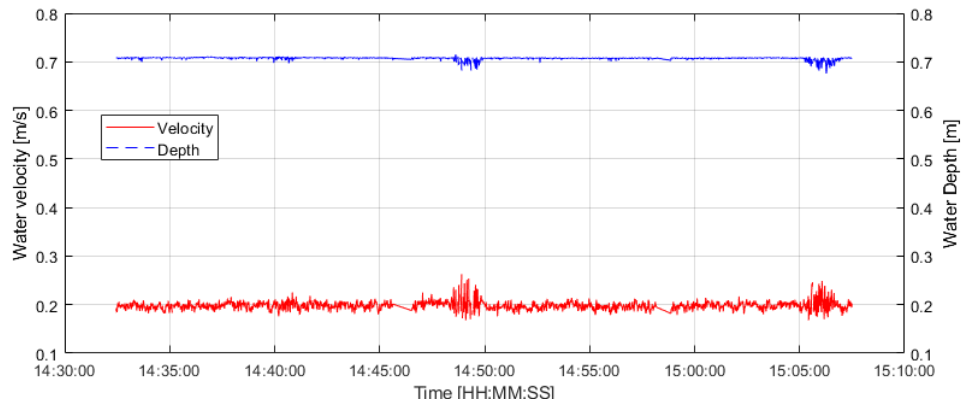
Figure 5. Examination of flow conditions using ADCP measurement results.